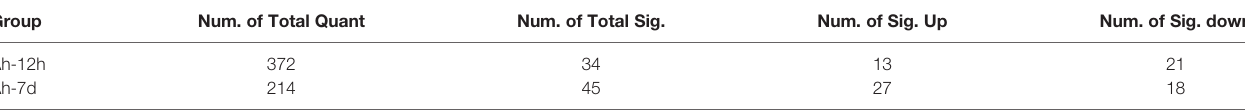
TABLE 2 | Number of differentially expressed proteins (DEPs) between different groups. Group Num. of Total Quant Num. of Total